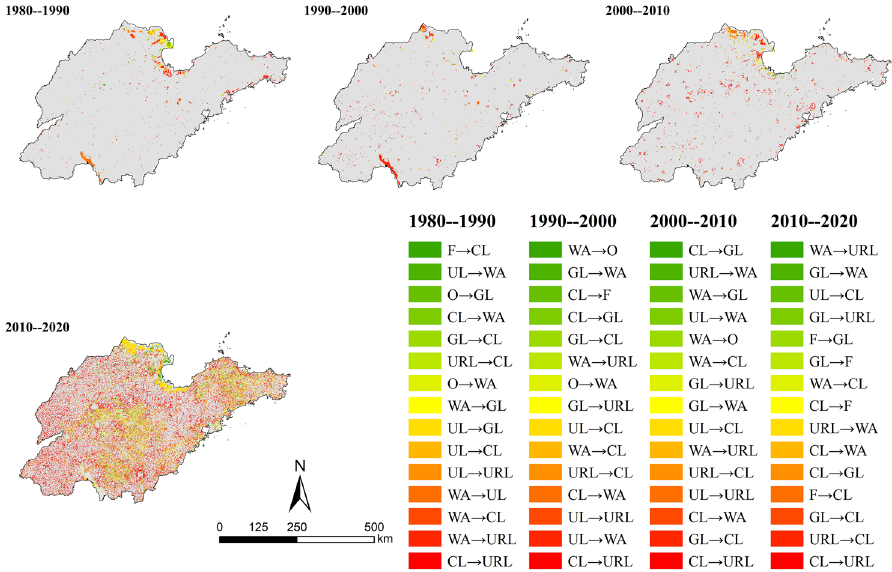
Figure 4. Spatial distribution map of land use conversion types in different periods.